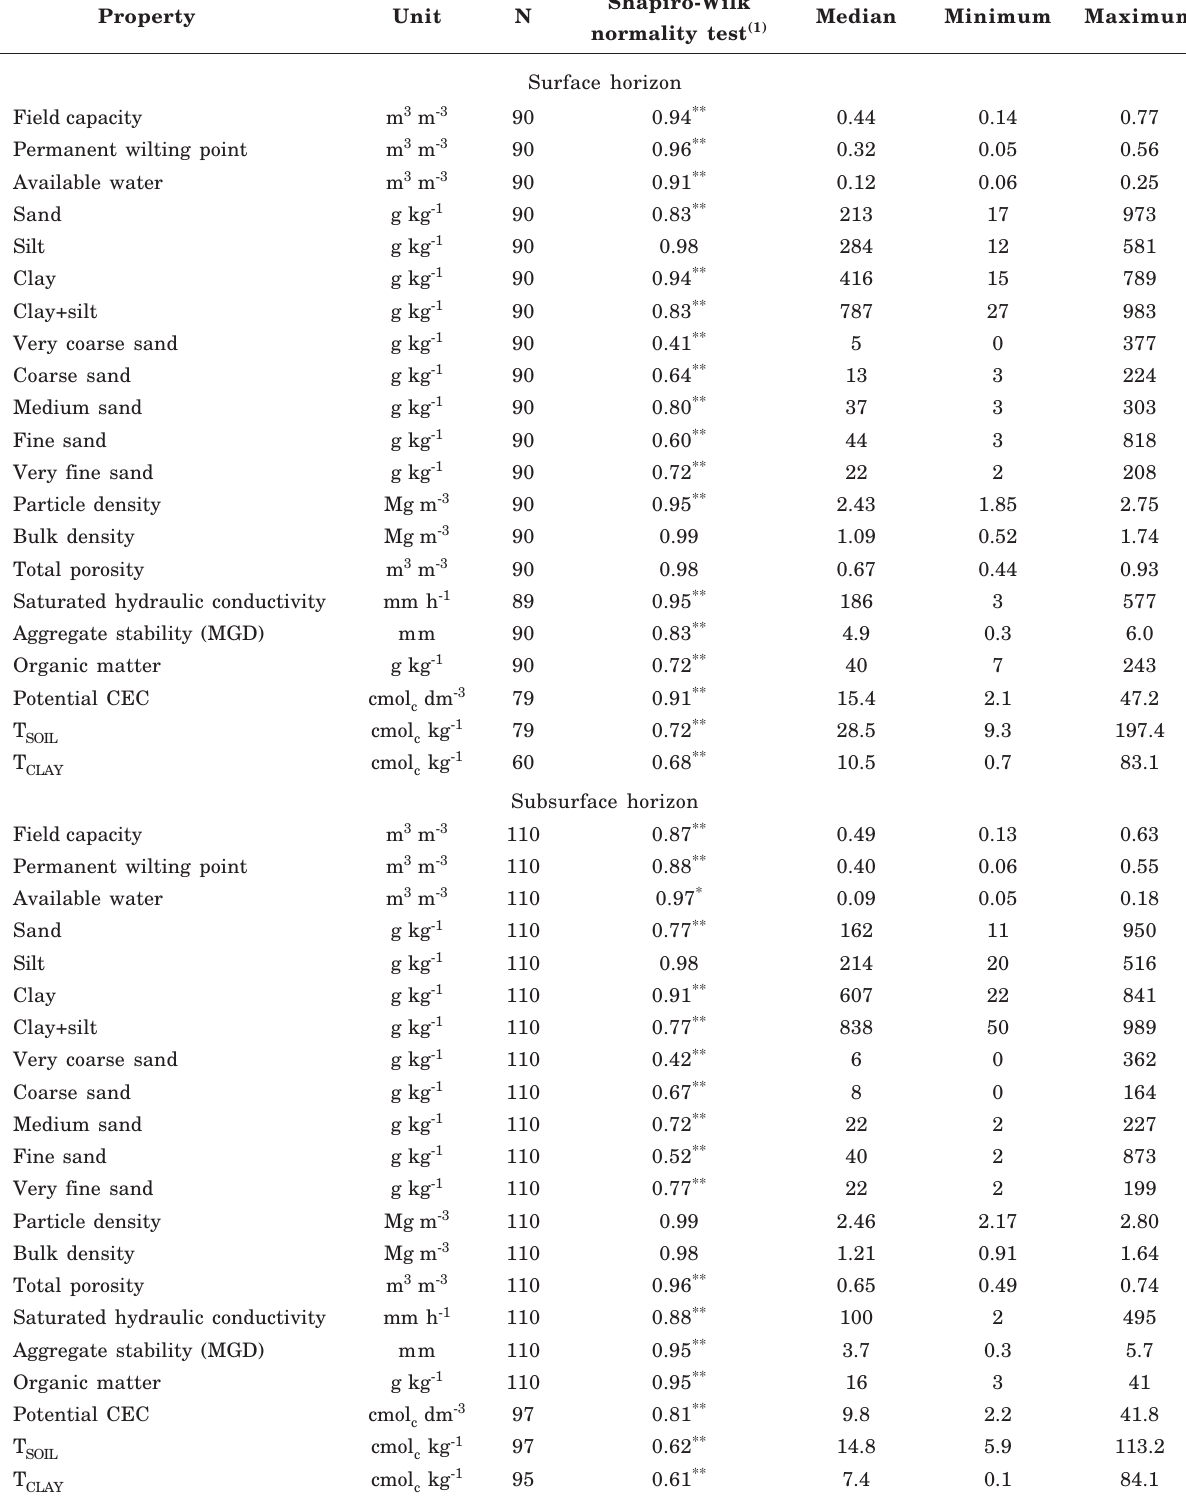
Table 1. Descriptive statistics of different soil properties in surface and subsurface horizons of some soil profiles in the State of Santa